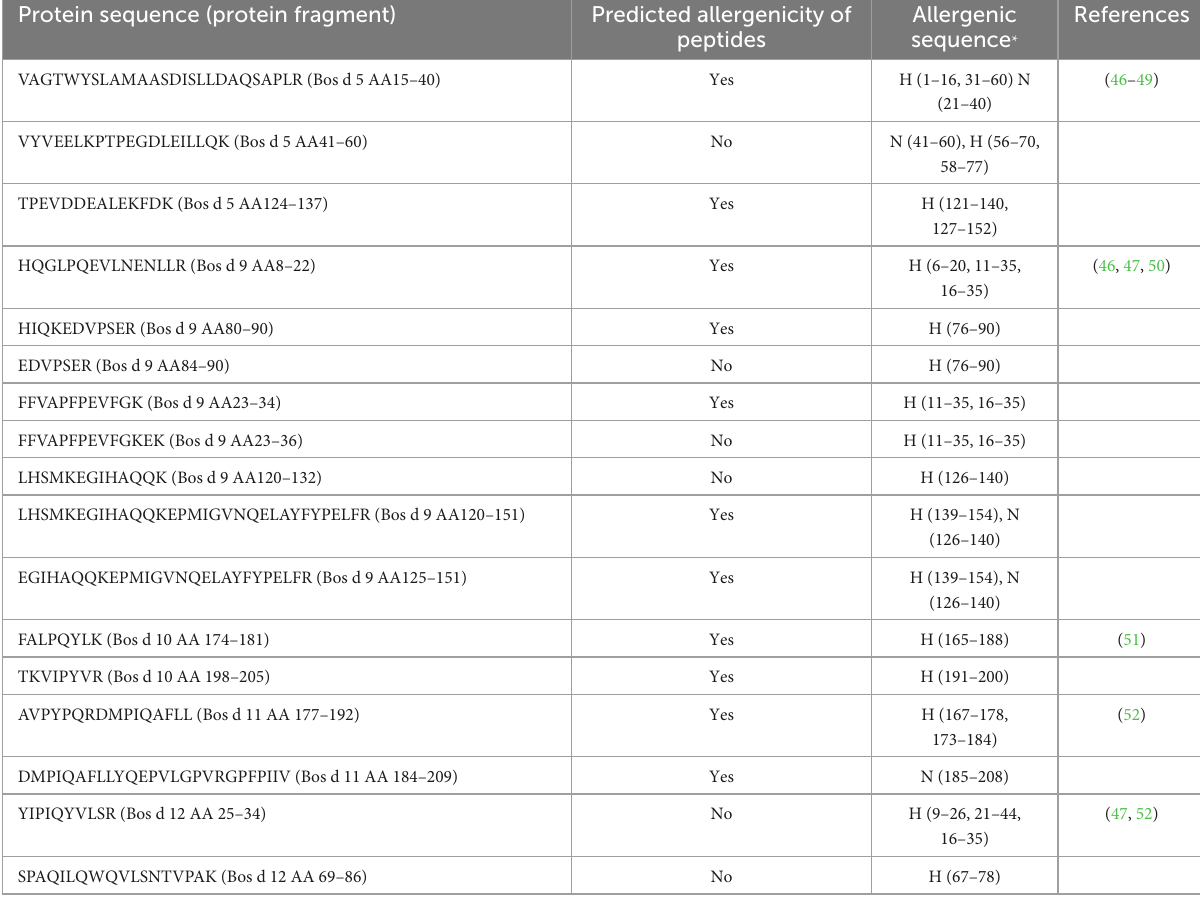
TABLE 2 Peptides identified by LC-MS/MS in the yogurt. Protein sequence (protein fragment) Predicted allergenicity of